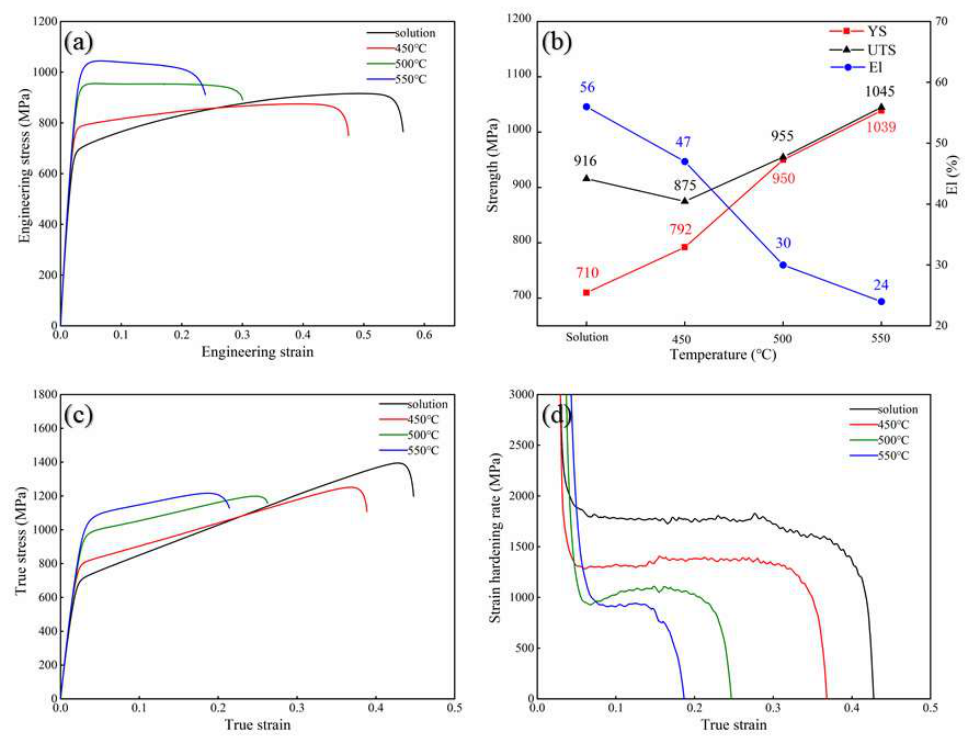
Figure 1. The tensile properties of samples S1000, A450, A500 and A550 plotted: ( a ) room temperature tensile stress–strain, ( b ) values of the YS, UTS and EI, ( c ) true stress–strain and ( d ) strain hardening rate curve.